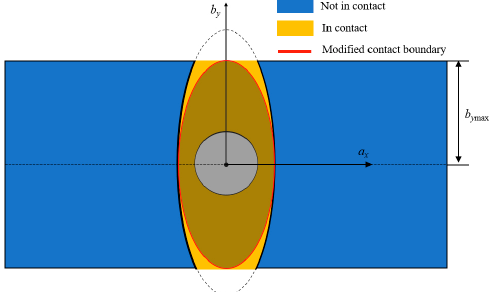
Figure 22. Ellipse modification in microslip.